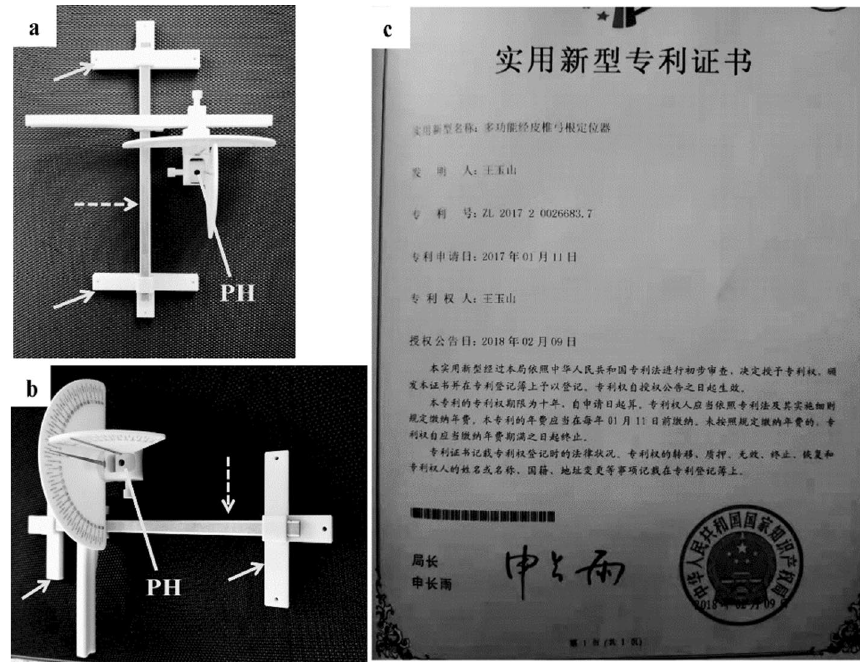
Figure 1. The proposed percutaneous multi-function pedicle locator. The structure of the locator was shown in ( a ) and ( b ), in which areas indicated by an arrow are the main parts (the base) of the locator, and areas indicated by a dotted arrow represent the longitudinal axis of the base; ( c ) The patent certificate of the proposed percutaneous multi-function pedicle locator. PH = A needle passing through the skin to the target point (pinhole